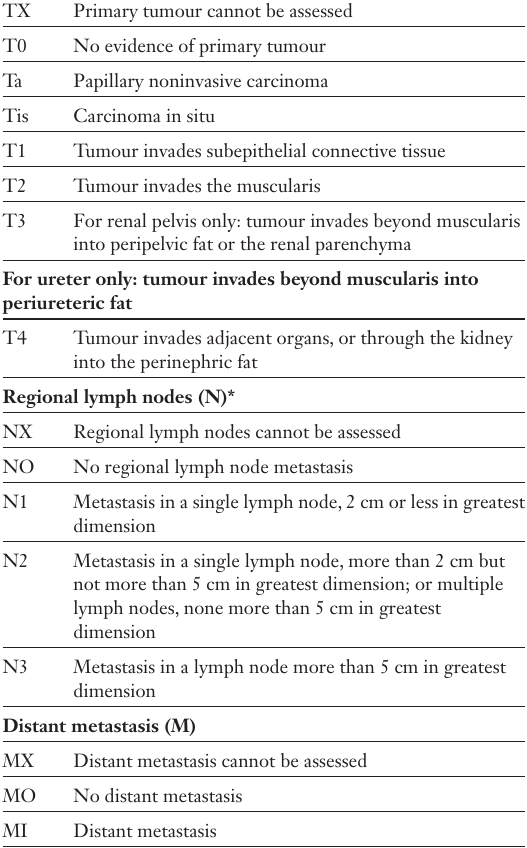
Definition ofTNM staging for tumours of renal pelvis and ureter